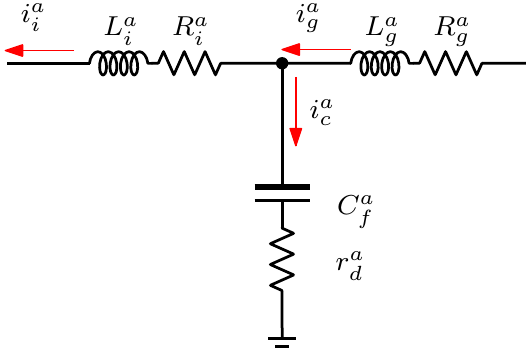
Figure 3. Nodal electrical circuit: simplified scheme.